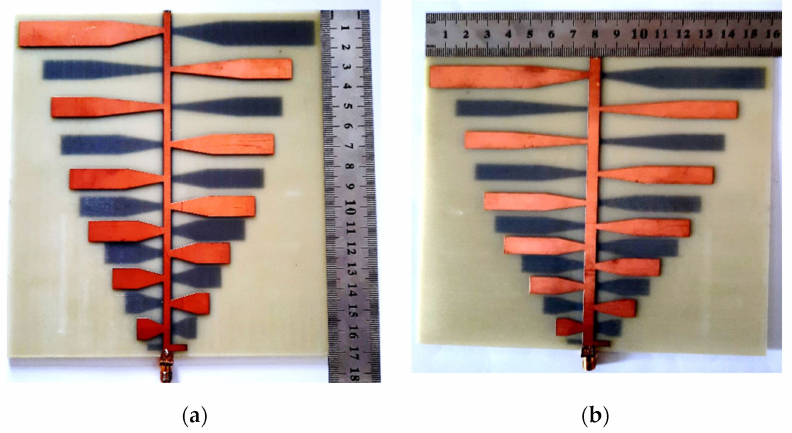
Figure 11. The prototype of the proposed design: ( a ) front view; ( b ) back